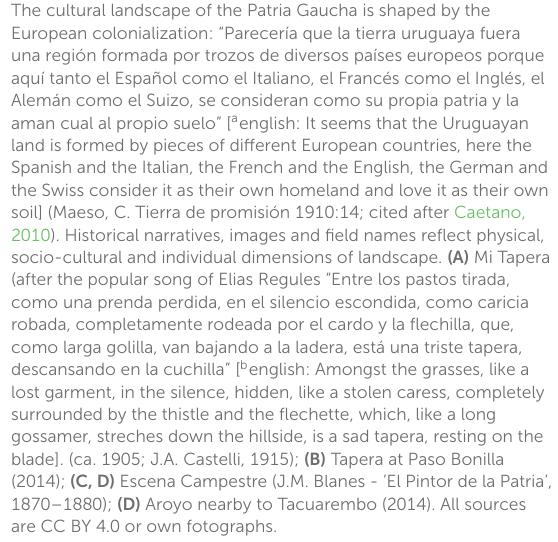
surrounded by the thistle and the flechette, which, like a long gossamer, streches down the hillside, is a sad tapera, resting on